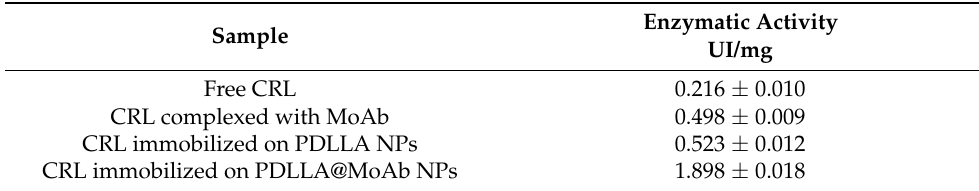
Table 3. Lipolytic activities of free or immobilized